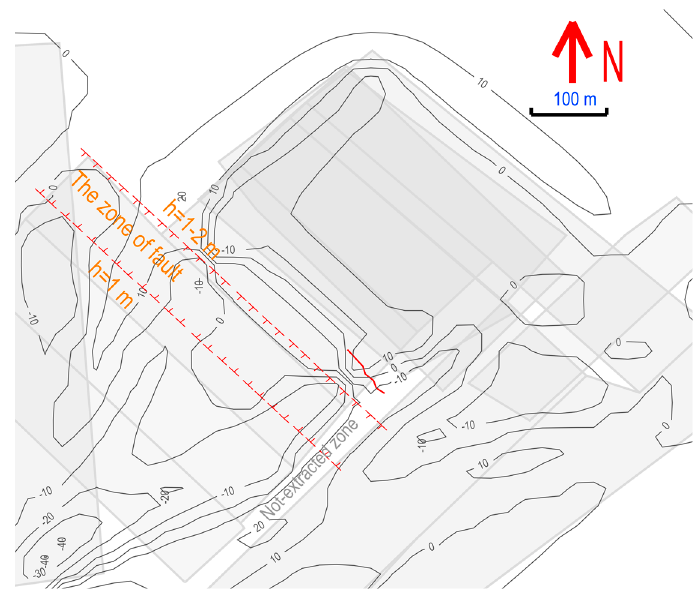
Figure 11. The distribution of the calculated land surface subsidence resulting from the past extraction (values in meters).